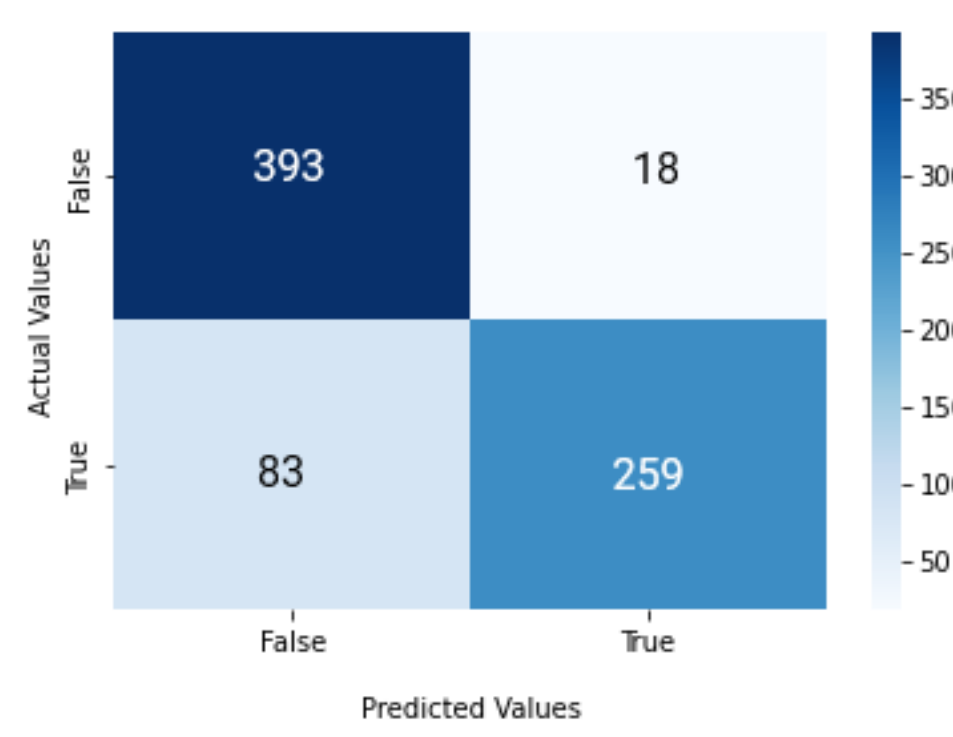
Figure 16. Proposed-model confusion